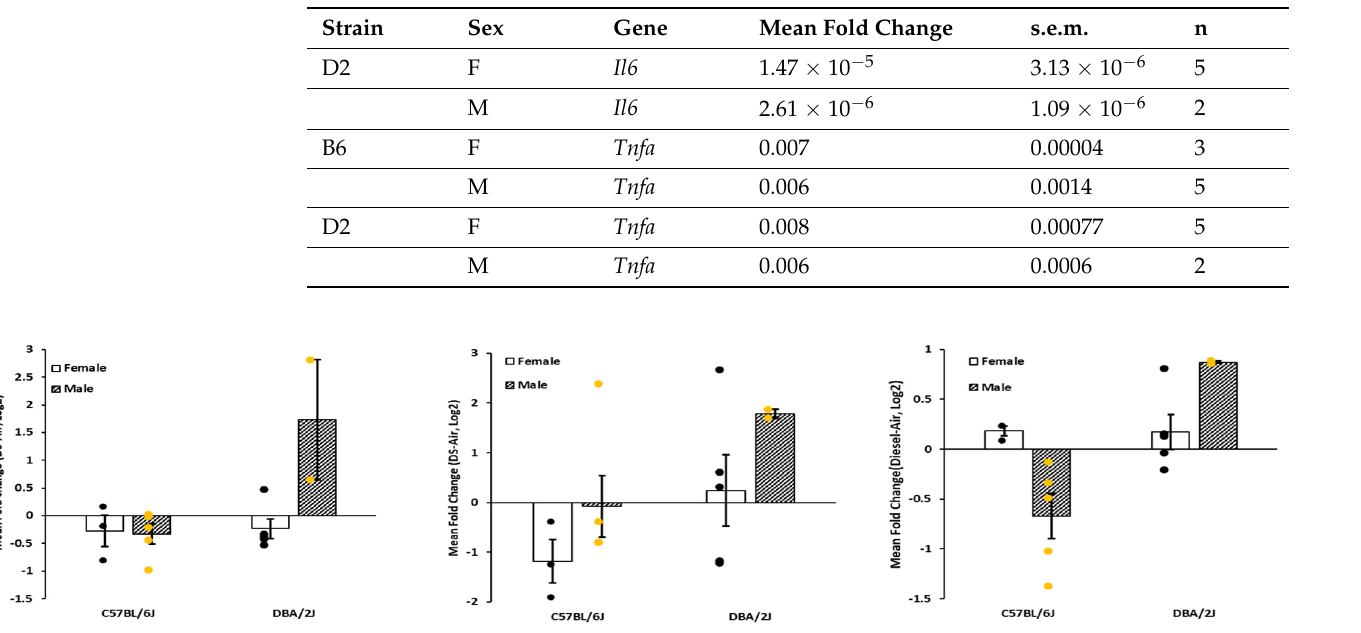
Figure 1. Proinflammatory cytokine gene expression responses to diesel exhaust exposure in prefrontal cortex in male and female C57 and DBA mice. These figures show strain, sex, and treatment Log 2 mean differences in expression (diesel exposure vs. air) of Il1 β ( left ) Il6 ( center ), and Tnf α ( right ). Results are expressed as mean ± SEM for expression for Il1 β , Il6 , and Tnf α by strain, sex, and DE. Table 1. Proinflammatory cytokine gene expression in animals exposed to air, i.e., the controls for Figure 1.